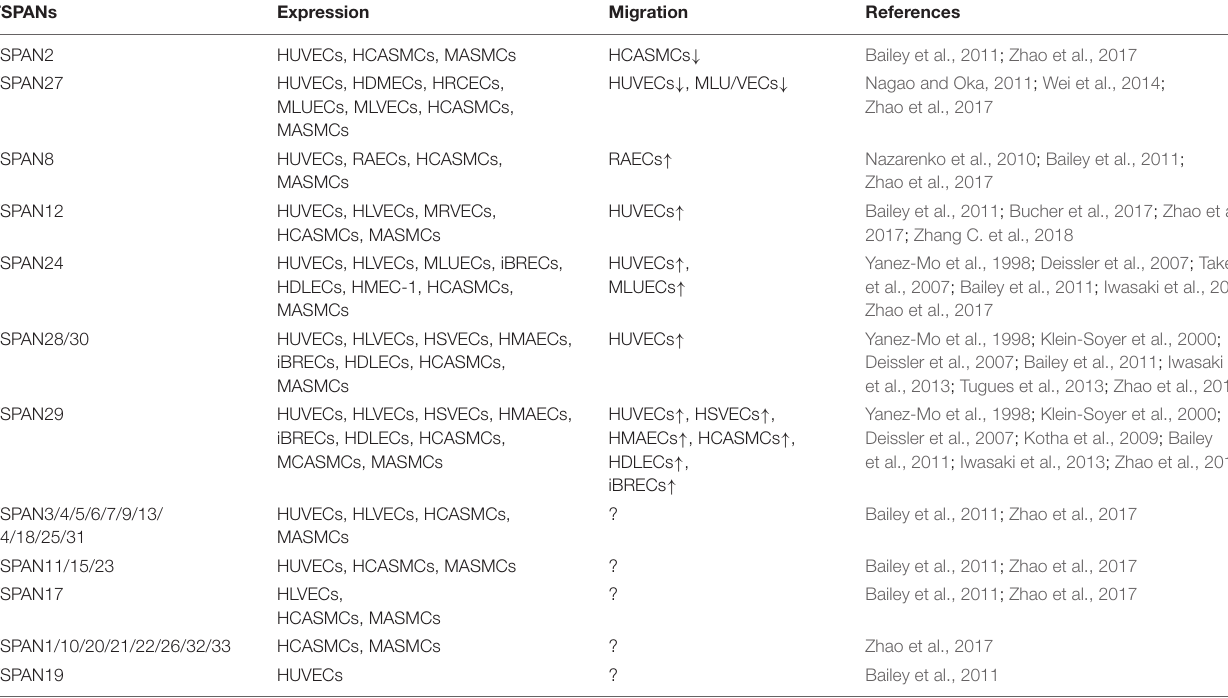
TABLE 2 | The effects of TSPANs in vascular cells